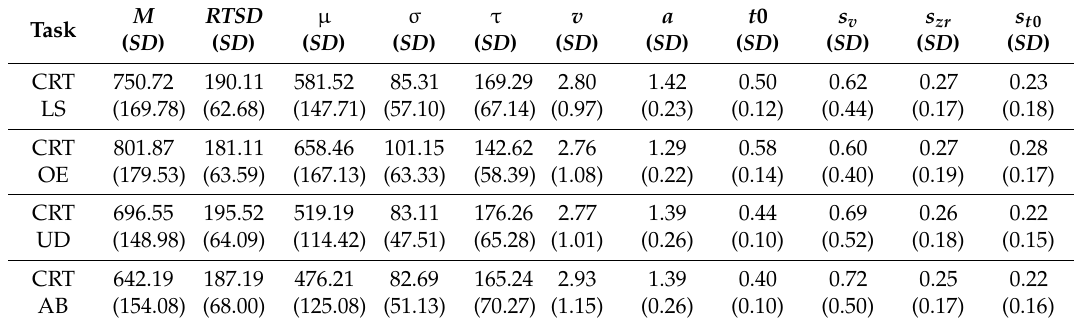
Table 1. Descriptive statistics for the ex-Gaussian and Ratcliff’s Diffusion Decision Model parameters.